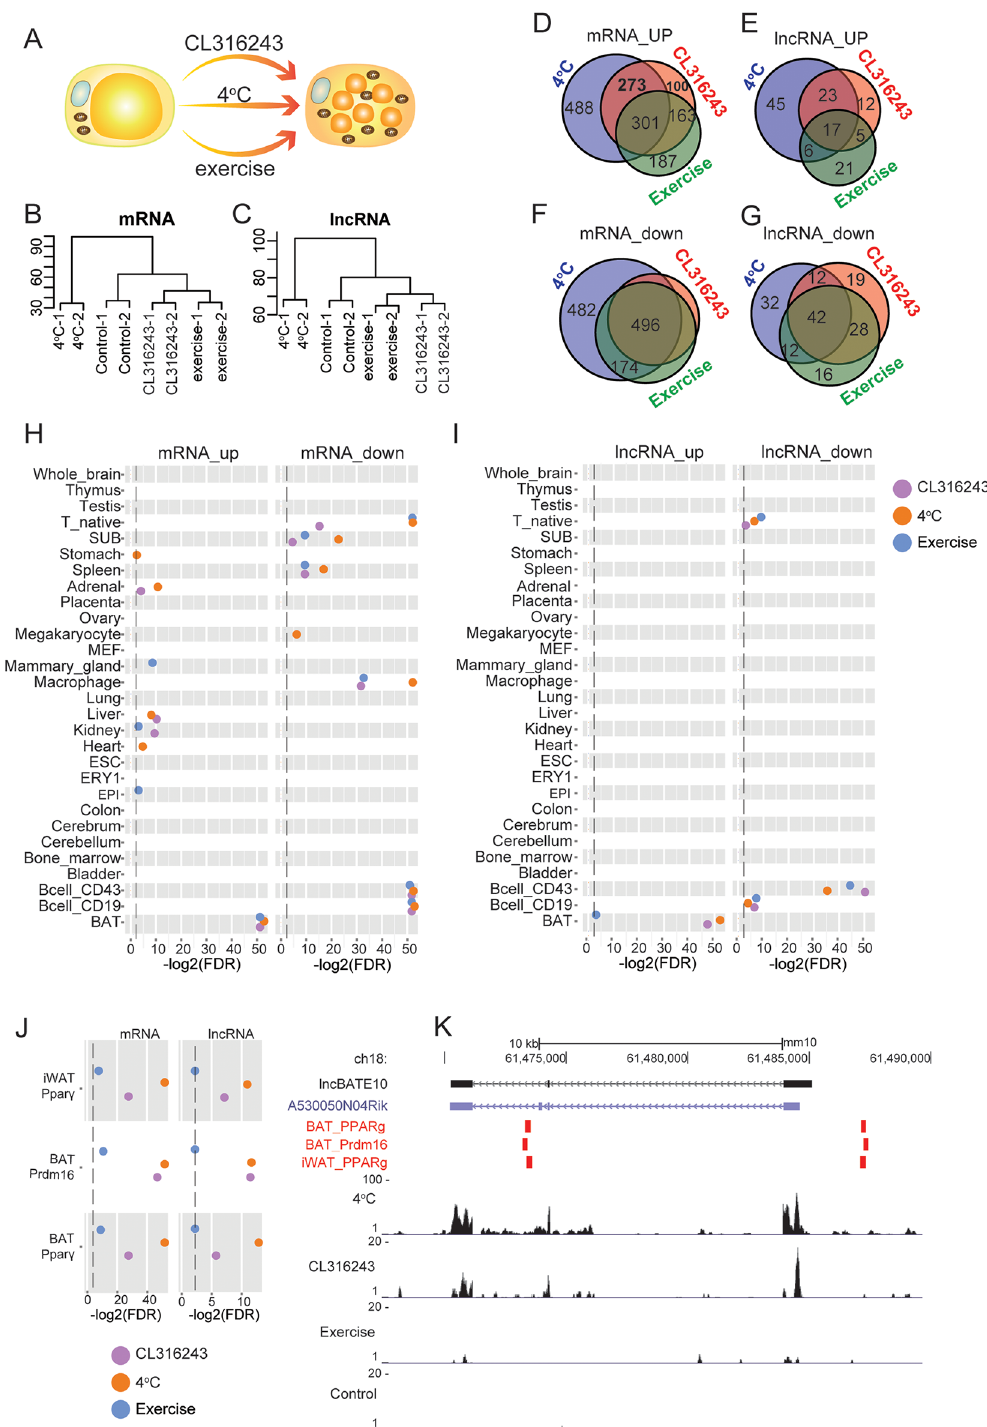
Fig 1. Transcriptome landscape associated with browning of white adipose tissue (WAT). (A) Schematic representation of the 3 treatments (chroniccold exposureat 4˚C, treatment with β 3-adrenoceptor agonist, CL316243, or swimmingexercise) used to inducebrowningof WAT in mice. (B,C) Hierarchical clustering(Ward’s method, spearmancorrelation)of treatments basedon RNA sequencing–derivedgene expressionprofiles(mRNA and long noncoding RNA [lncRNA]) of adiposetissue undergoingbrowning. (D-G) Venn analysisof overlap betweensignificantly differentially expressedmRNA and lncRNA (false discoveryrate [FDR] (cid:20) 0.05,